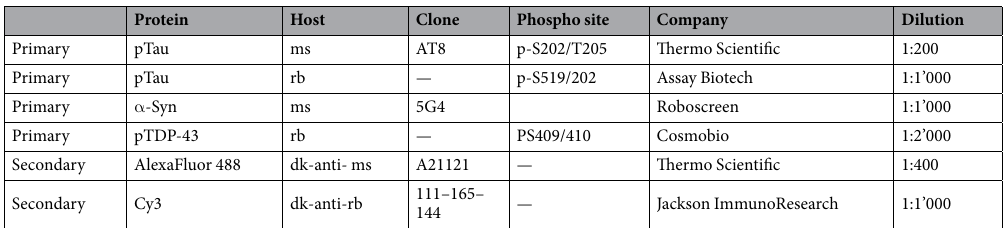
Table 2. Antibody specifications. α -Syn, α -synuclein; dk, donkey; ms, mouse; rb, rabbit; pTau, phosphorylated tau; pTDP-43, phosphorylated